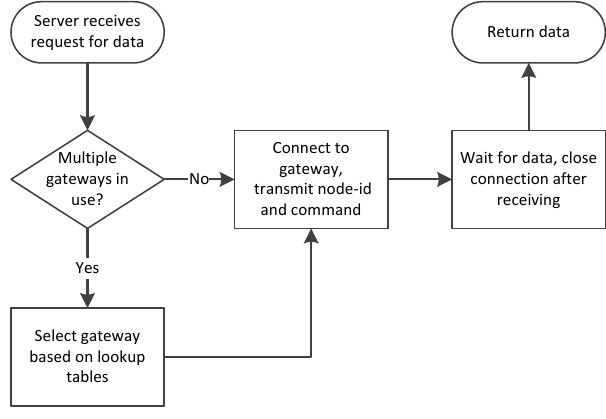
Figure 4. Flowchart of the server